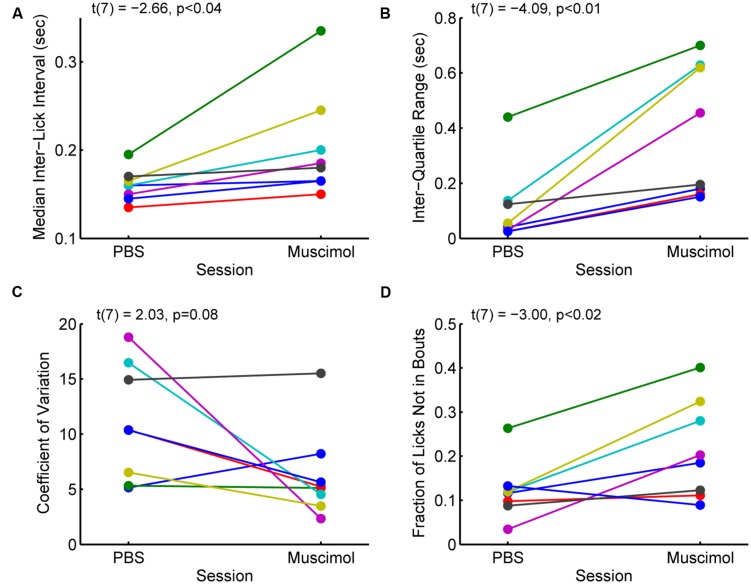
Effects of inactivation on measures of licking variability. (A) Inactivation of the rostral mPFC increased the median inter-lick interval [ILI; paired t-test: t(7) = -2.66, p < 0.04), defined as the time between pairs of licks, in 8 rats with muscimol infused into the rostral mPFC (see Figure 3A). (B) Inactivation also increased the inter-quartile range [t(7) = -4.09, p < 0.01], a non-parametric measure of variability, of the ILI. (C) There was no consistent effect of inactivation on another measure of variability, the coefficient of variance (t(7) = 2.03, p = 0.08). (Note that a coefficient of variance, defined as the variance divided by the mean, near 1 is typical for a random (Poisson) time series; (D) The fraction of non-bout licks (isolated licks and lick pairs) increased with inactivation [t(7) = -3.00, p < 0.02]. This finding is further support for the idea that the rats were less able to persistently lick with the rostral mPFC inactivated.